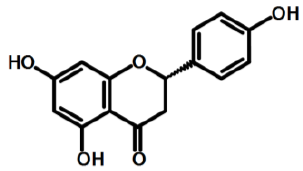
Figure 2. Chemical structure of naringenin (NG).